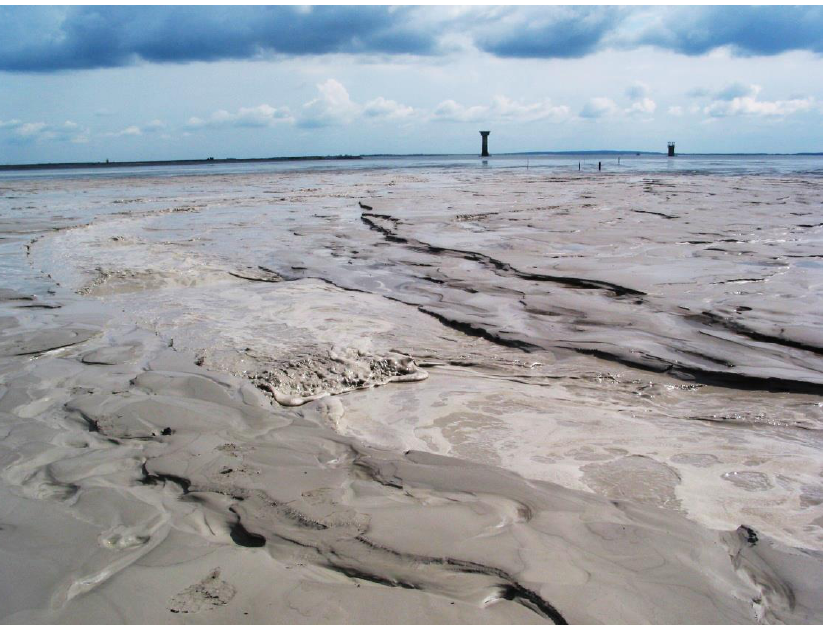
Figure 3. The view of the beach with spigotted waste [13].